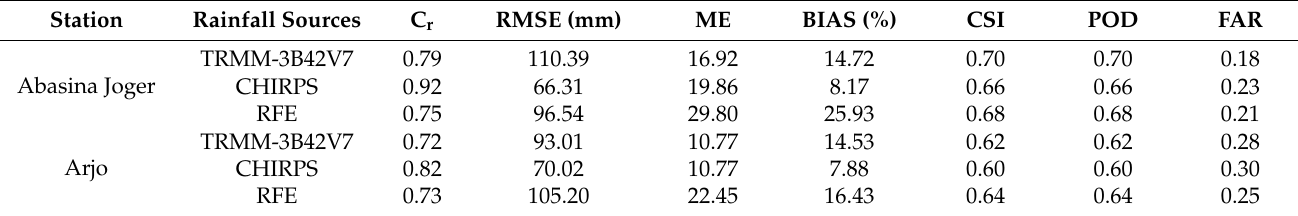
Figure 5. Box plots of monthly rainfall distributions for the satellite products and gauge records at the Bahir Dar and Combolocha stations: TRMM-3B42V7 from 1998 to 2014, CHIRPS from 1981 to 2014, and RFE from 1983 to 2014. Table 2. Statistical and contingency indicators for the satellite products compared to gauge records on a monthly basis. Station Rainfall